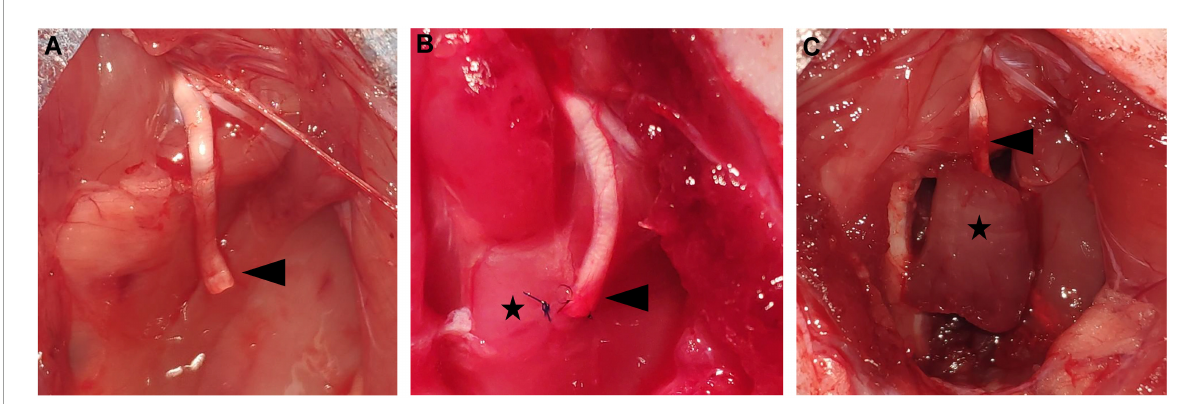
FIGURE1 The presentation of the operations in each group. (A) The control group. The sciatic PNS (black arrowhead) was left in situ without treatment. (B) The NSM group. The sciatic PNS (black arrowhead) was embedded in the nearby adductor magnus muscle (black star). (C) The RPNI group. The sciatic PNS (black arrowhead) was implanted inside the free muscle graft (black star). DRG, dorsal root ganglia; NSM, nerve stump implantation inside the muscle; PNS, proximal nerve stump; RPNI, regenerative peripheral nerve interface.